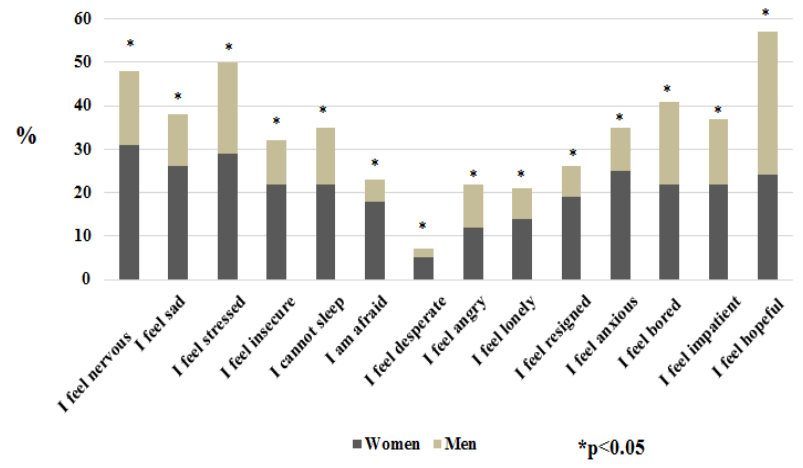
Figure 2. Percentages of patients reporting “very much” for specific feelings by gender. The reported feelings were significantly more frequent in women than men (* p < 0.05).